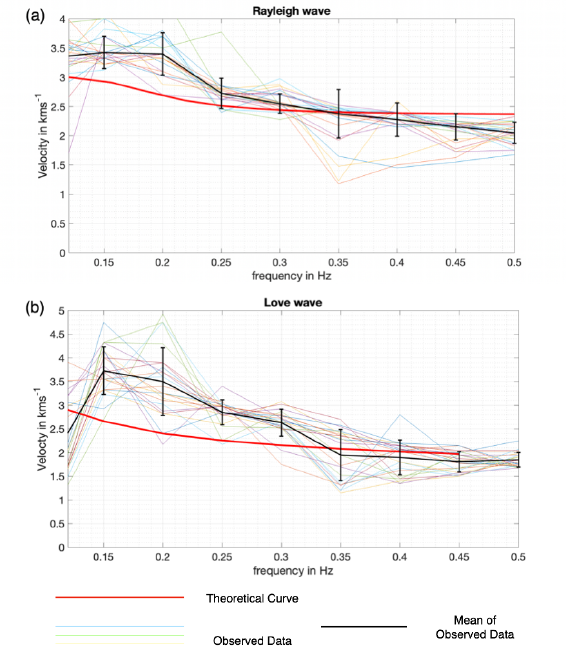
Figure 10. Dispersion curves for (a) Rayleigh waves and (b) Love waves, made using the 1-D velocity model from Löer et al. (2020). Observed dispersion curves (multi-coloured), mean ob- served curves (black) and theoretical curves (red); black bars rep- resent the degree of error for the real data dispersion